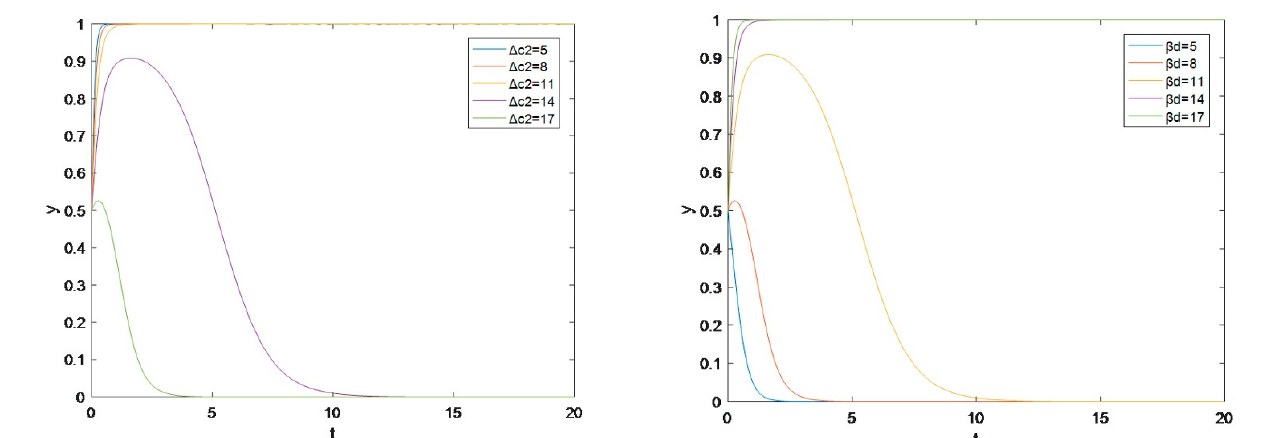
( b ) The impact of long-term benefits on local government’s strategies. Figure 14. The impact of additional confirmation costs and long - term benefits on local government’s Figure 14. The impact of additional confirmation costs and long-term benefits on local govern- strategies. ment’s